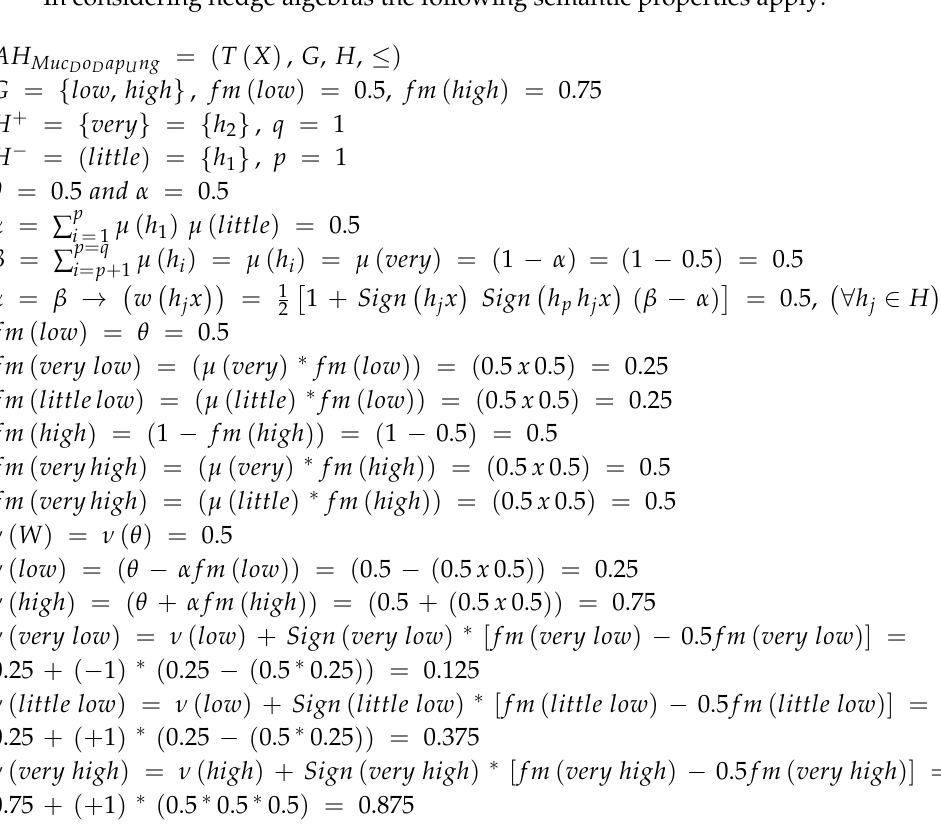
very imp very very